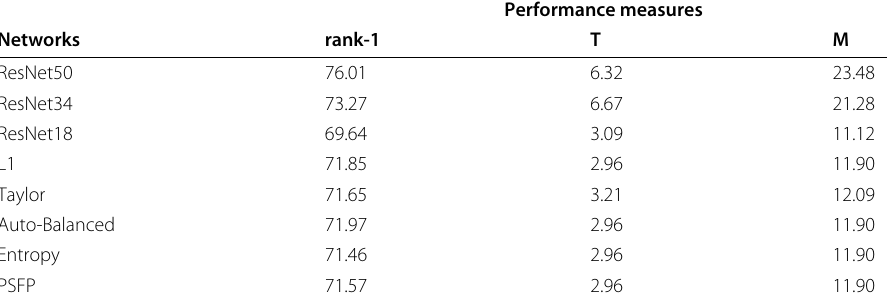
Table 4 Rank-1 accuracy and complexity (M: number of parameters and T: GFLOPS) of baseline and pruned ResNet CNNs on ImageNet dataset